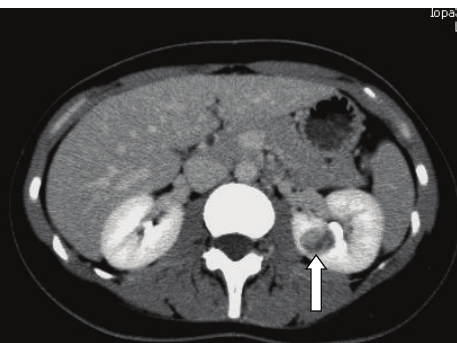
Figure 1: Enhanced CT showing the tumor (excretory phase) (arrow).